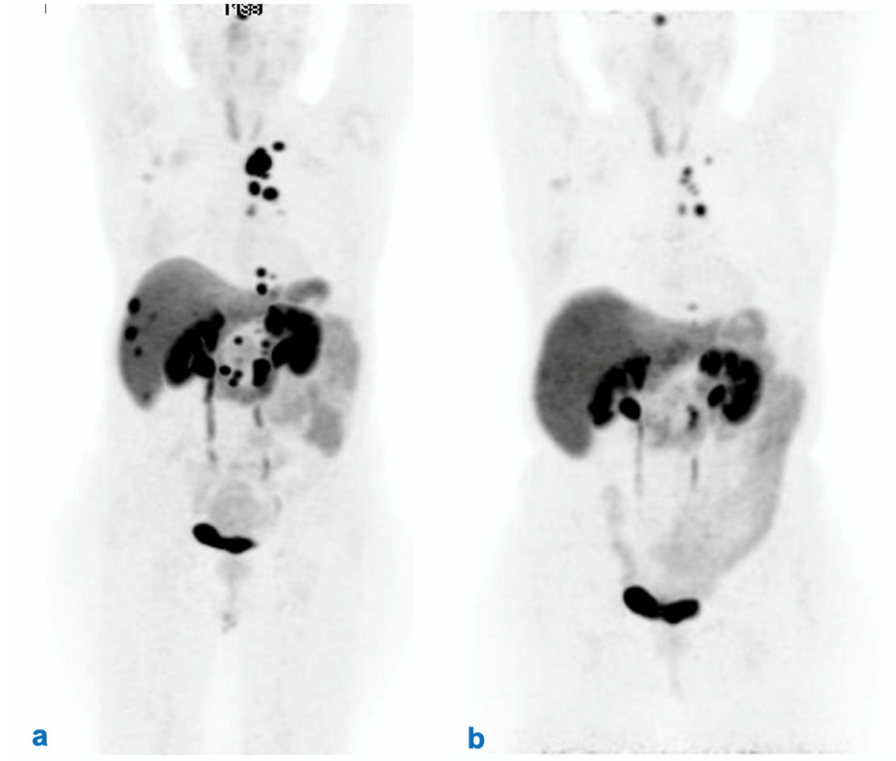
Figure 3. Monitoring response to RLT with PET/CT 68 Ga-DOTATOC. Female, 58 years old, pNEN, G2, surgically removed in 2016. Staging before and after RLT with 177 Lu-Lutathera. PET/CT 68Ga- DOTATOC MIP ( a ) depicts the extent metastatic disease (thoracic, axillary and abdominal LNs, liver metastases) before RLT. ( b ) MIP after RLT with no evidence of liver metastases and abdominal lymph nodes along with a significant reduction in the radioligand uptake of thoracic lymph nodes, which is suggestive for a partial